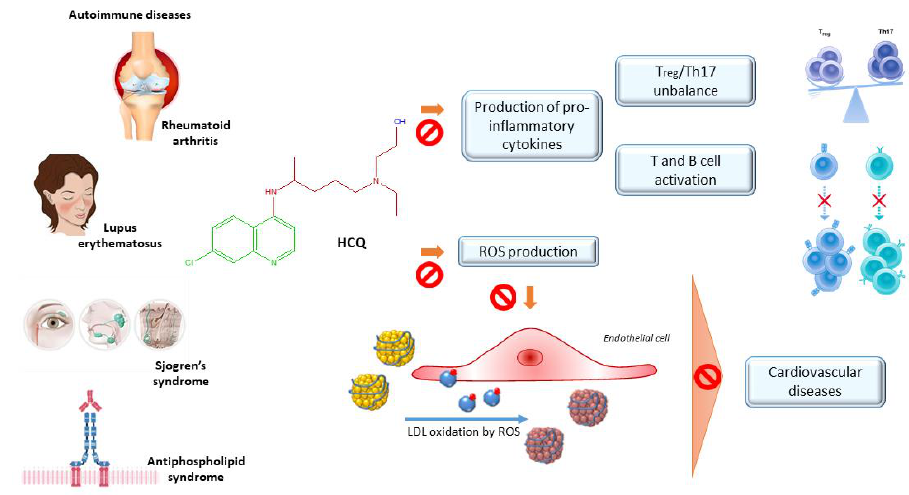
E ff ects of Hydroxychloroquine (HCQ) on immune diseases and cardiovascular- Figure 7. Effects of Hydroxychloroquine (HCQ) on immune diseases and cardiovascular-associated associated complications.